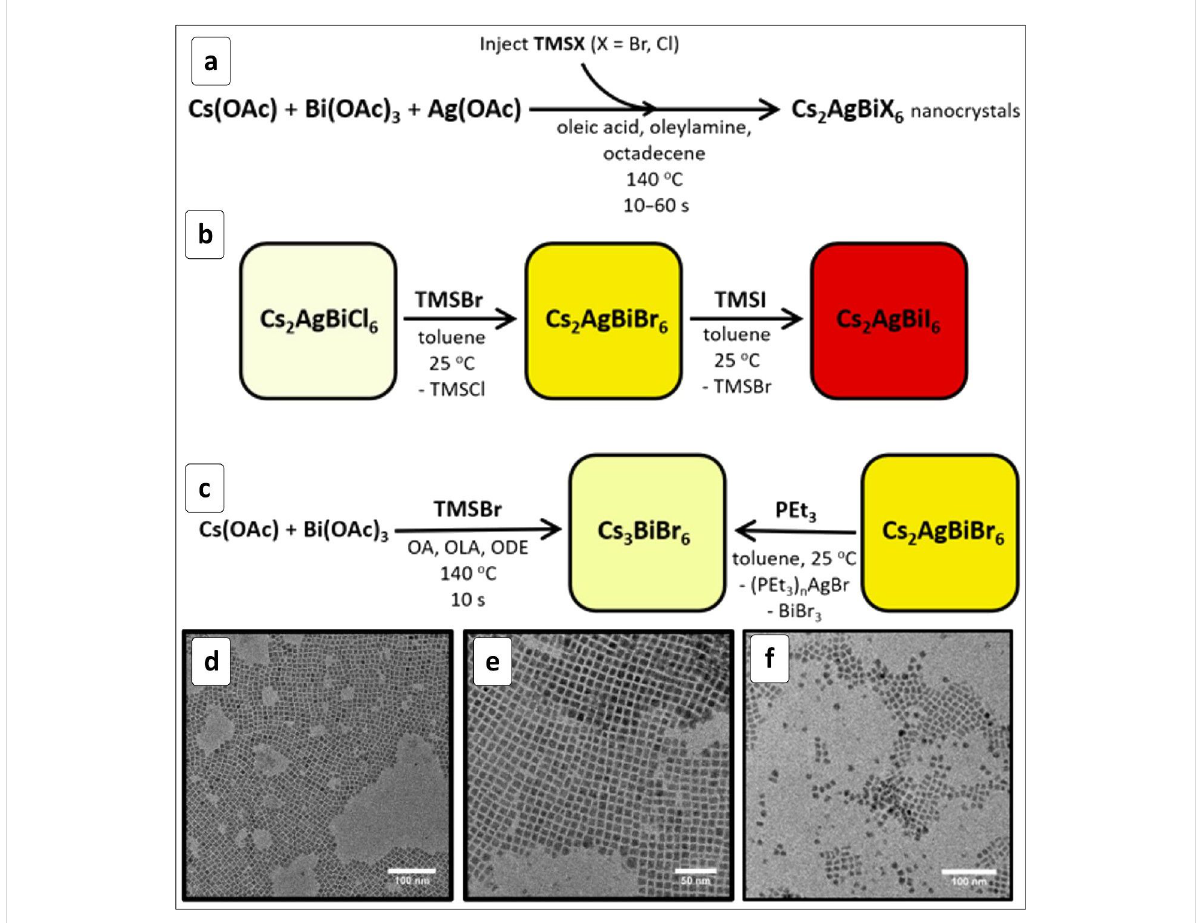
Figure 16: Scheme of the synthesis of Cs 2 AgBiX 6 NCs (a–c) and TEM images of Cs 2 AgBiCl 6 (d), Cs 2 AgBiBr 6 (e), and Cs 2 AgBiI 6 NCs (f). OAc is acetate anion, Et – ethyl, OA – oleic acid, OLA – oleylamine, ODE – octadecene, TMS – trimethylsilyl. Reprinted and adapted with permission from [202], copyright 2018 American Chemical